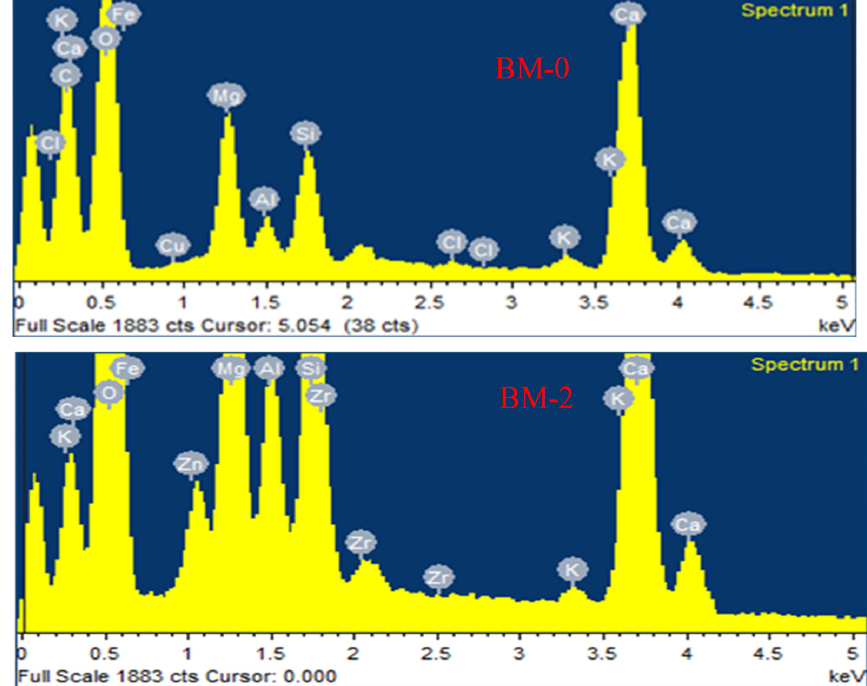
Figure 5. Energy dispersive spectrometry of BM-0 and BM-2.